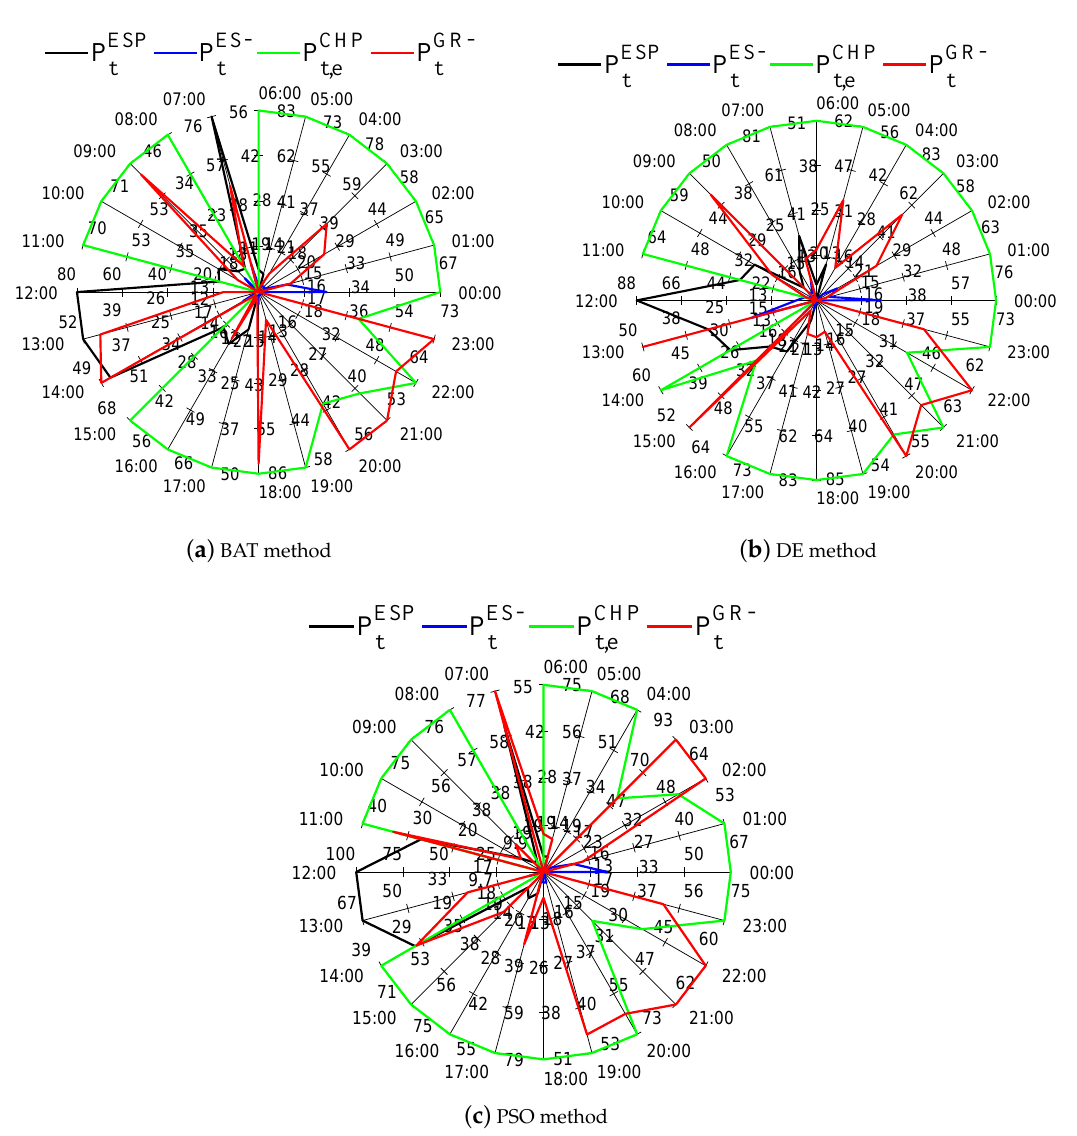
Figure 8. Percentage of electrical power produced by the implemented